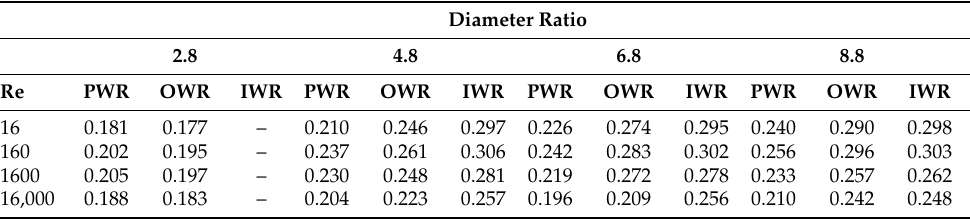
Table 6. Axially averaged mean radial velocity